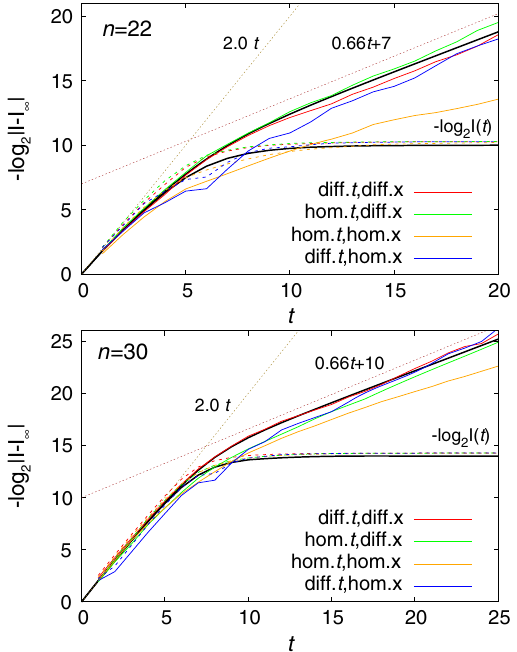
FIG. 26. Single random-circuit realization results for a single random-product initial state (four colored curves with labels) and the average purity (smooth black solid curves). We use the S 0 . 5 [the same parameters as in configuration with PBC and a z ¼ Figs. 10(c) and 10(d)] and system size n ¼ 22 (top) and n ¼ 30 (bottom). Labels for the colored curves denote whether 1-qubit Haar unitaries are different on each site ( “ diff.x ” ) or the same ( “ hom.x ” ), as well as whether they are the same at every time step ( “ hom.t ” ) or different at every circuit layer ( “ diff.t ”